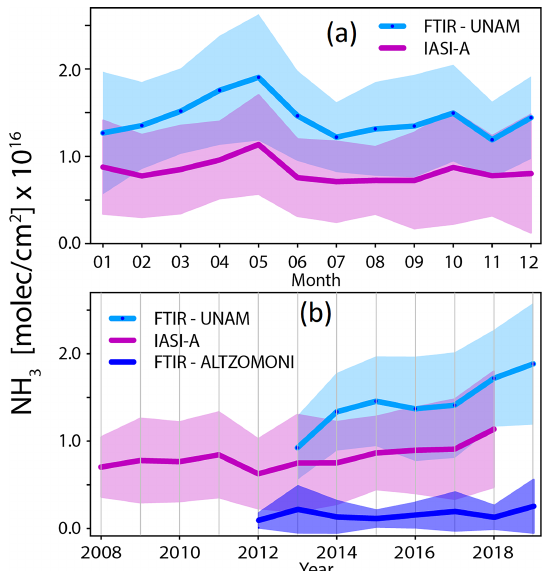
Figure 9. IASI and FTIR NH 3 total columns with coincidence cri- teria of < 20km and < 2h: (a) monthly averages at UNAM, (b) an- nual averages at UNAM and Altzomoni. The shaded area indicates ± 1 σ